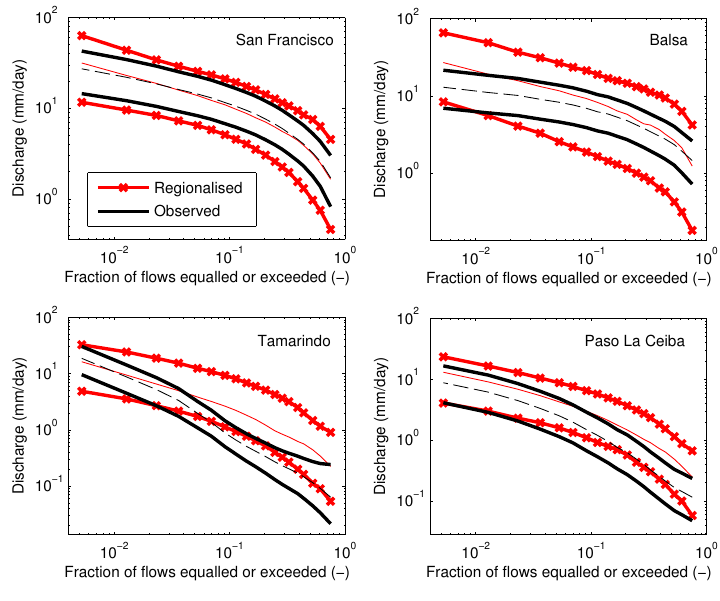
Figure 8. Examples of regionalised and observed uncertain FDCs. Both discharge and EP exceedance percentage values are shown in log space. The thin/dashed lines represent the best-estimate discharge data and the thick lines the upper and lower uncertainty bounds.